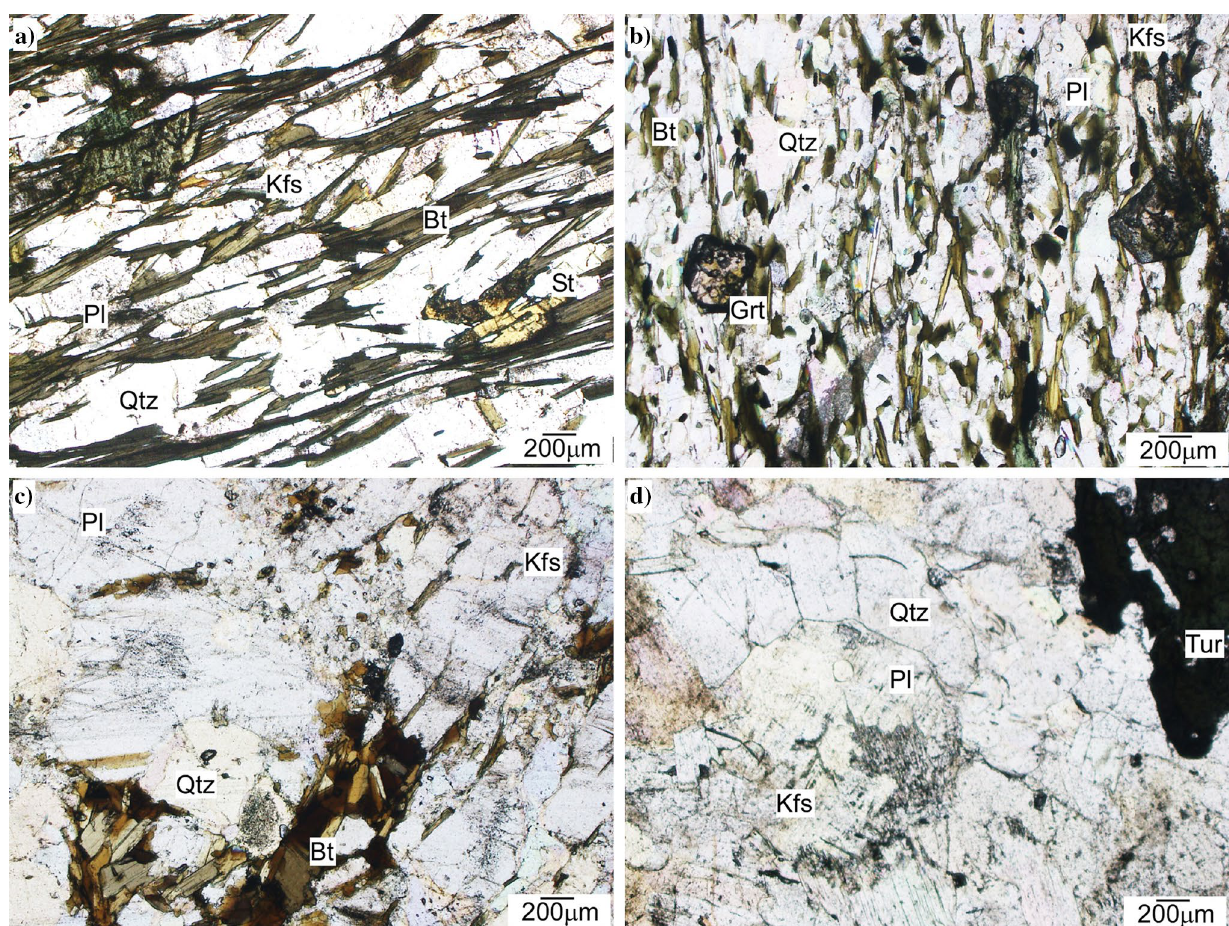
Fig. 4 Microphotographs of the exposed rock types along Chaturangi catchment ( a ). Harsil metasediment consisting of quartz, alkali feld- spar, plagioclase feldspar, biotite and staurolite. ( b ). Martoli forma- tion metasediments consisting of quartz, alkali feldspar, plagioclase feldspar, biotite and garnet. ( c ). Biotite granite consisting of quartz,